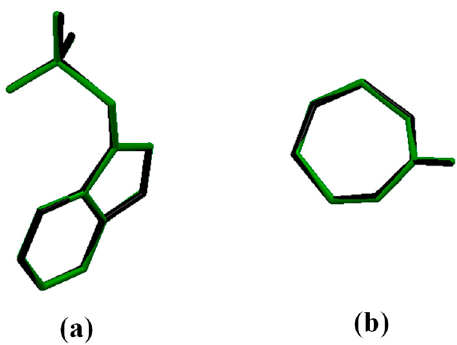
Figure 7. Overlay of the non-hydrogen atoms for zonisamide ( a ) and ϵ -caprolactam ( b ) molecules between the structure from the step 11 (green) and the DFT-D optimized free cell parameters structure (black).